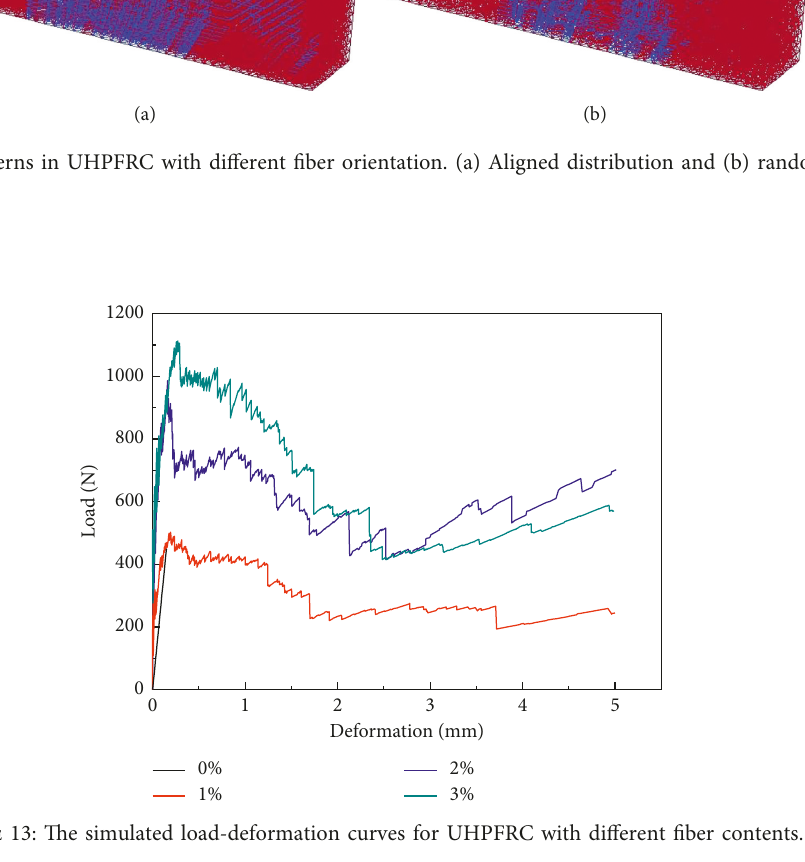
f (cid:30) 0%, (b) V f (cid:30) 1%, (c) V f (cid:30) 2%, and (d) V f (cid:30) 3%.